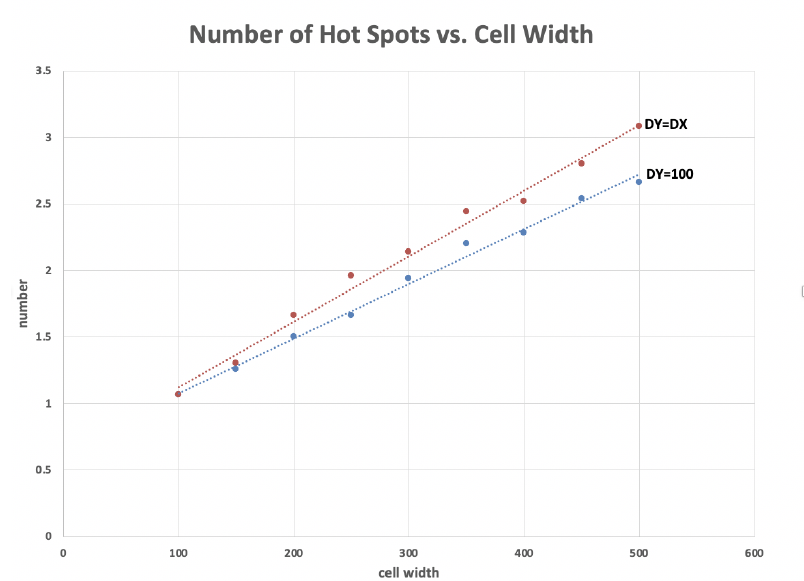
Figure 11. The ensemble-averaged number of hotspots contained in the most critical row (the row that causes failure of the cell) is plotted as a function of cell width. The upper curve has square cells DY = DX while the lower curve has DY = 100 µ m. All points are calculated with an imposed strain rate ˙ ϵ = 1 × 10 5 s − 1 , an ensemble size of 100 and the process zone is 10% of the crack radius. The curves are linear in the cell width, indicating that the average distance between hotspots is constant as a function of width. However, the taller cells sample more rows and the critical row will probably contain more